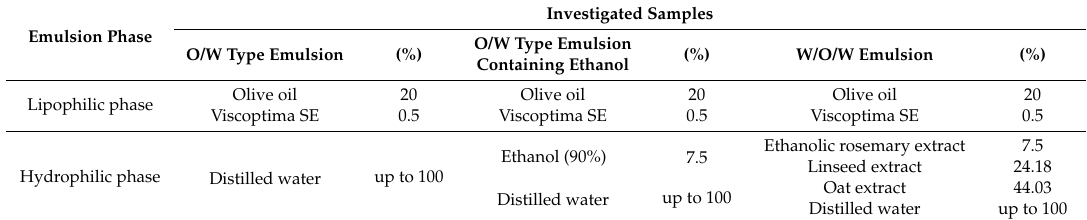
Table 2. The composition of multiple and double emulsions.